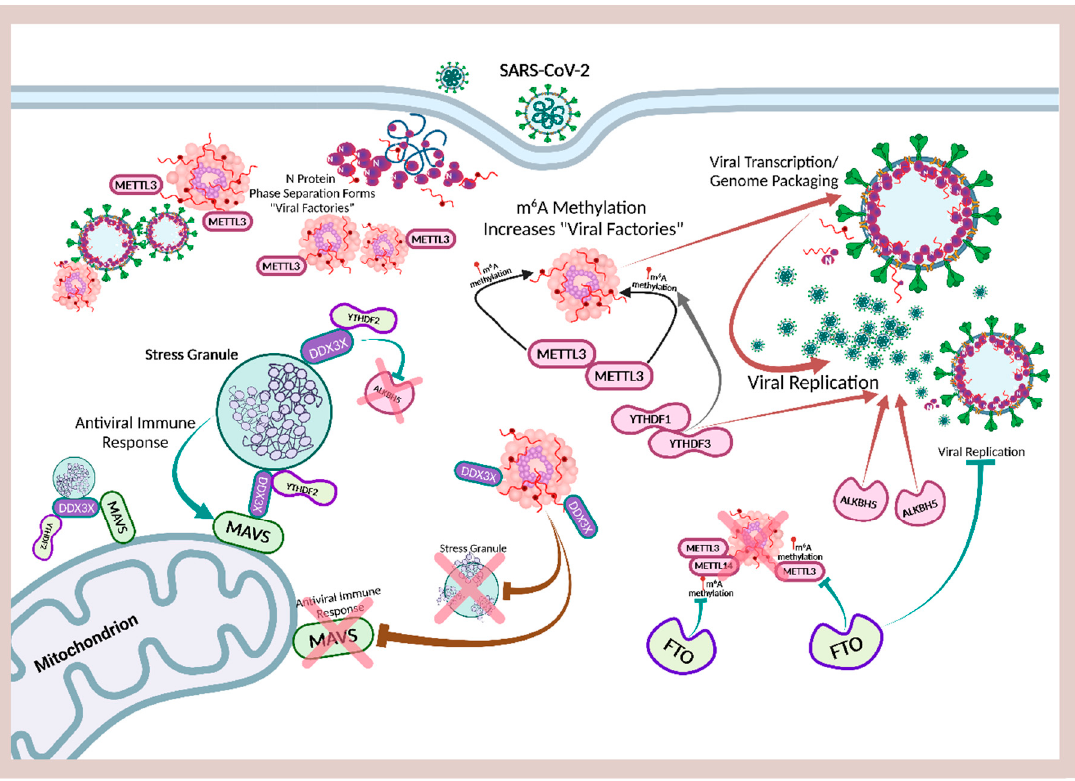
Figure 3. Overview of m 6 A modification effects on SARS-CoV-2 viral replication.